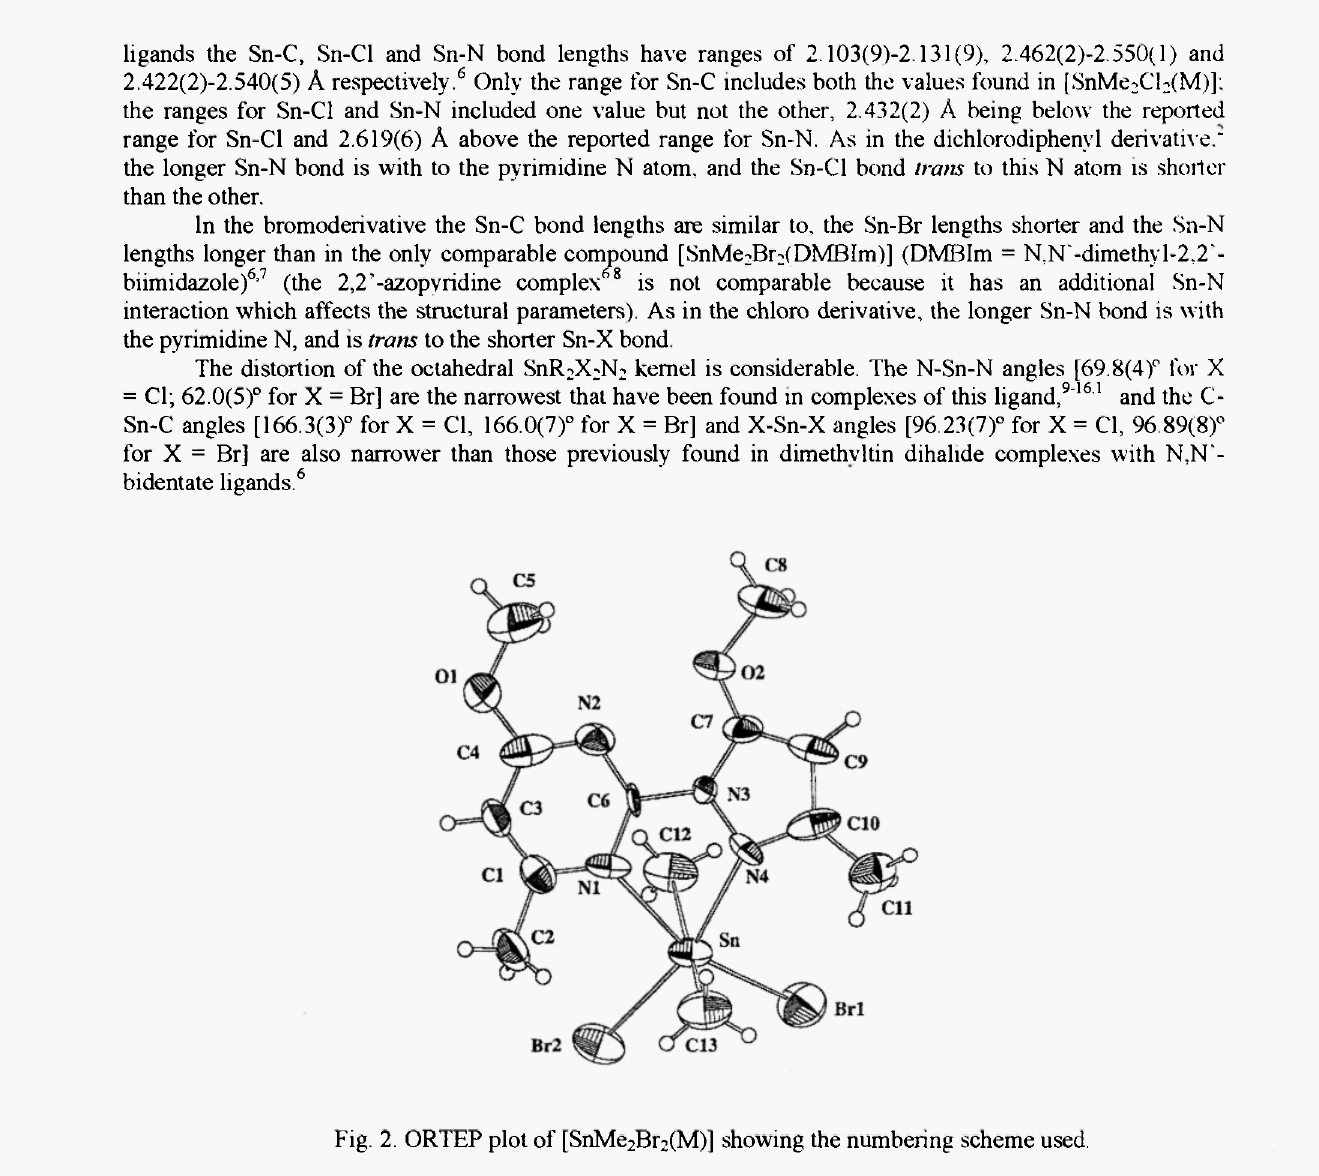
Fig. 2. ORTEP plot of [SnMe 2 Br ; (M)] showing the numbering scheme